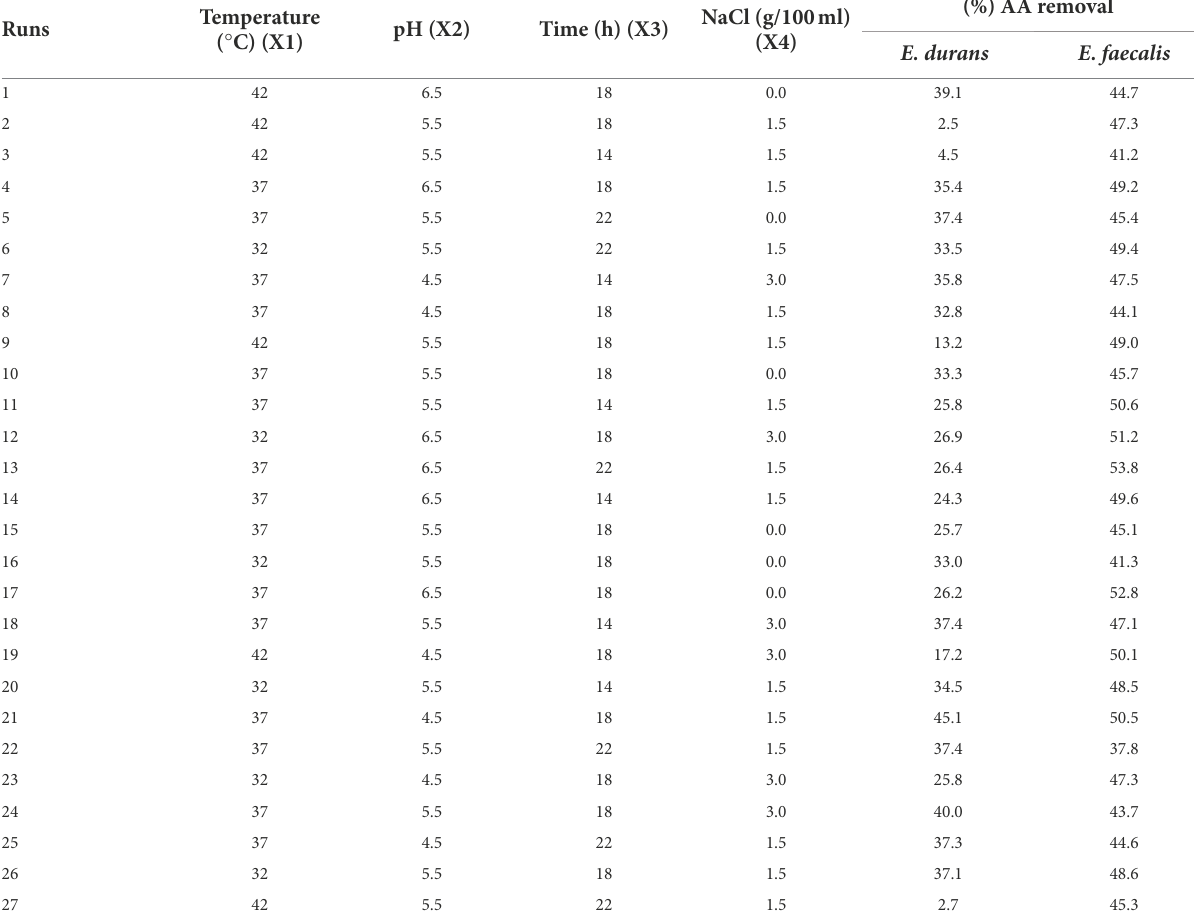
TABLE 1 Box–Behnken experimental design with coded variables and responses of acrylamide removal (%) by E. durans and E. faecalis under anaerobic